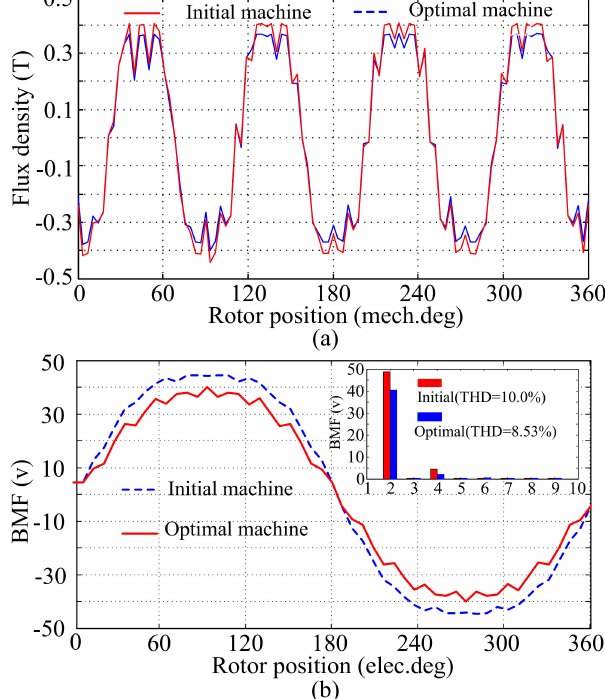
Figure 10. No-load performances before and after optimization. ( a ) Air-gap flux density. ( b ) Back-EMF and spectral analysis.